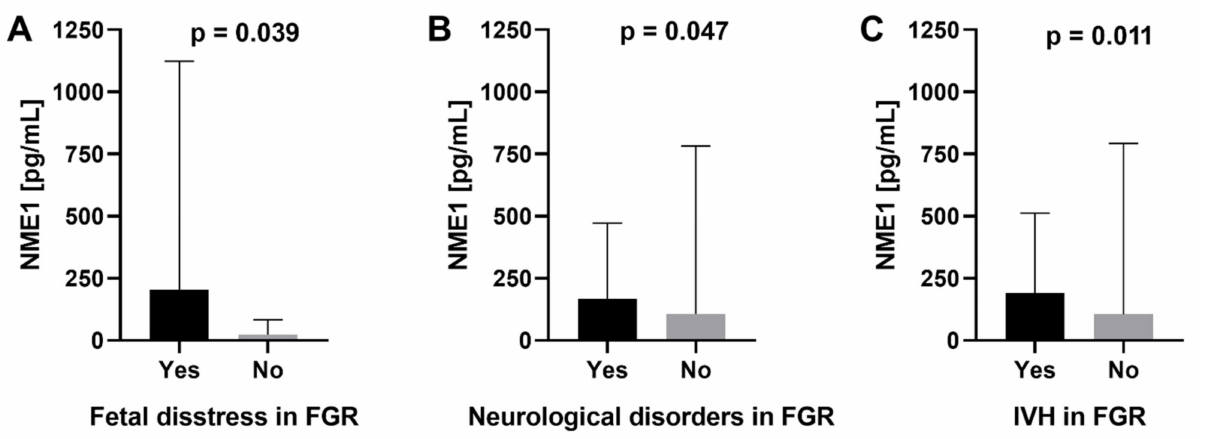
Figure 1. ( A ) Comparison of serum NME1 concentrations with reference to perinatal fetal distress in fetal growth restriction (FGR), ( B ) neurological disorders in FGR, and ( C ) intraventricular hemorrhage (IVH) in FGR newborns.